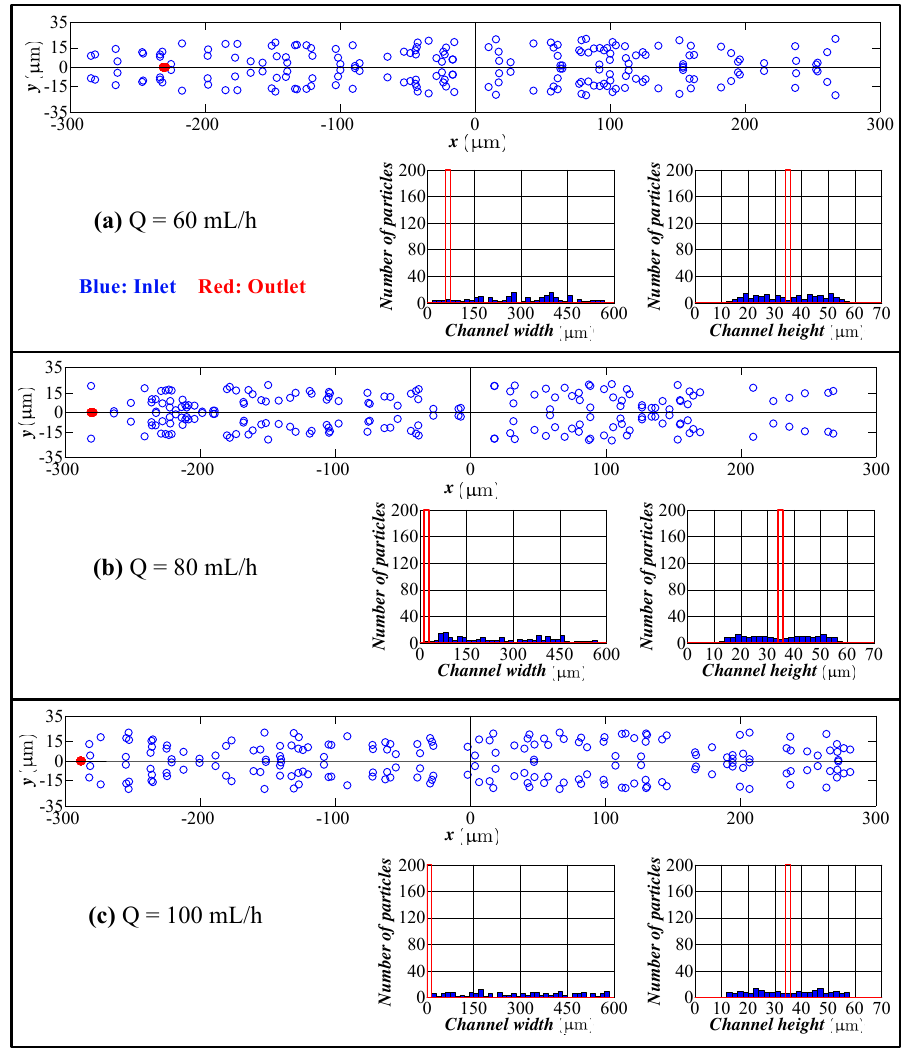
Figure 7. Particle distribution at the inlet and outlet in the height and width directions for different flow rates (spiral channel with an AR 9.0, 20 µ m particles). Flow rate: ( a ) 60 mL/h; ( b ) 80 mL/h; ( c ) 100 mL/h. Blue bars: particle distribution at the inlet. Red bars: particle distribution at the